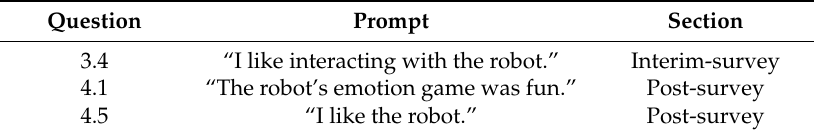
Table 4. Survey prompts focusing on participants’ enjoyment of the Emotion